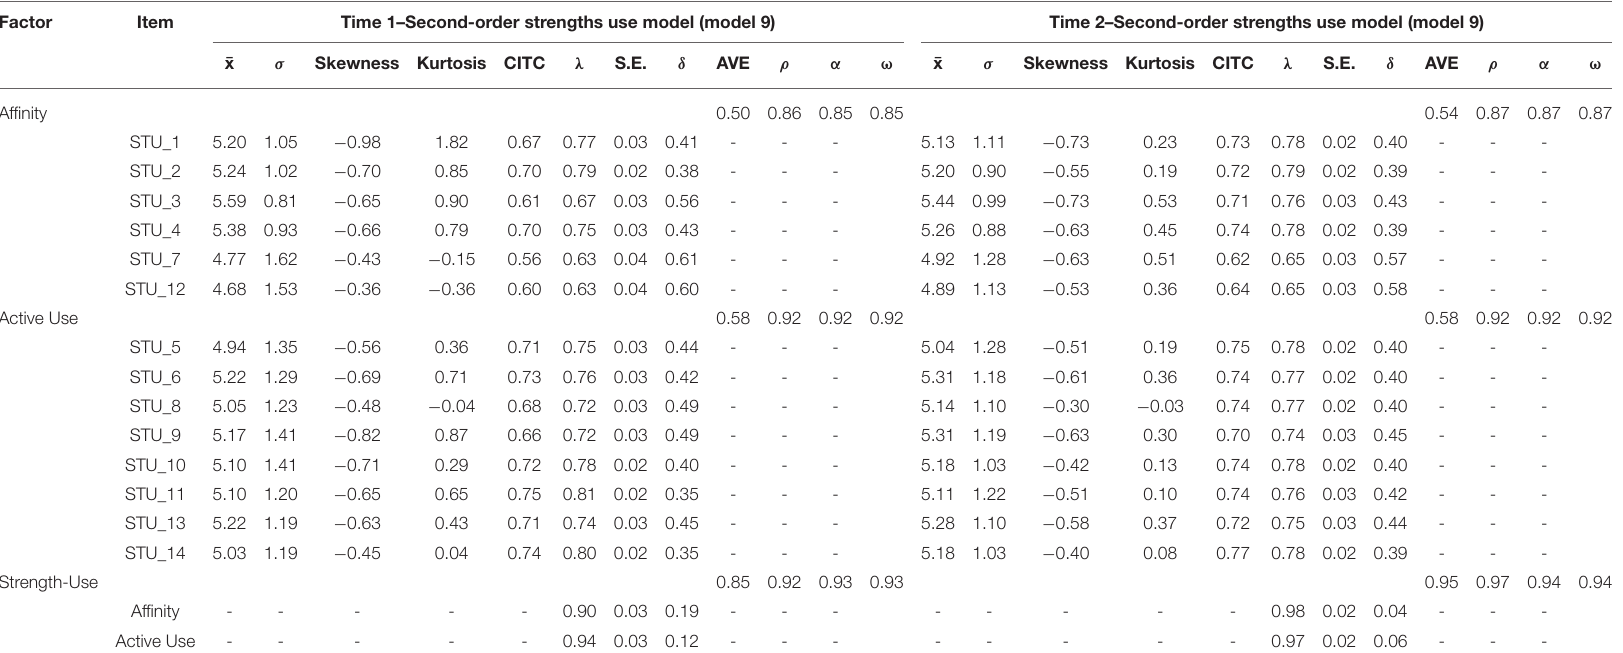
TABLE 7 | Item level descriptive statistics, standardized factor loadings, average value explained, and internal consistency for the longitudinal model 9. Factor